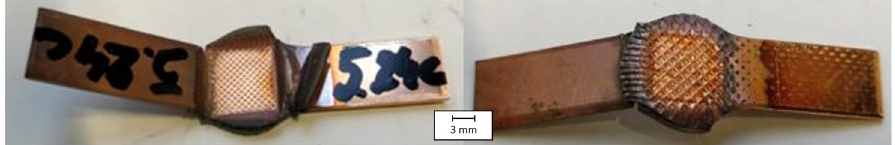
Figure 5. Bended and deformed weld specimen (left: top view, right: bottom view). For the thin sheets used in this work, a large value for the pressure or vibration sheets. A high-pressure value will result in the thinning of the workpieces, because the amount of friction and heat that is introduced into the weld. For some welds, the heat shown in Figure